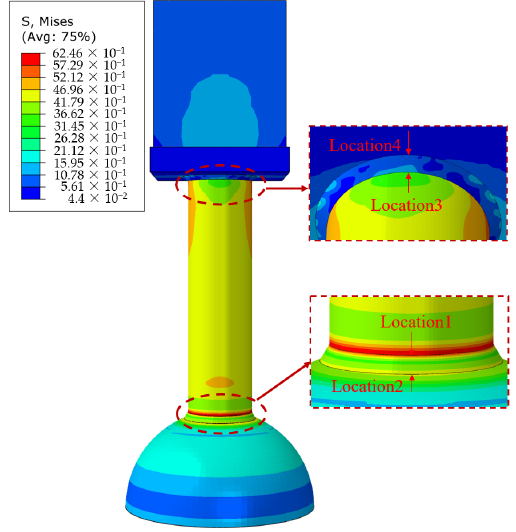
Figure 2. Results of stress concentration analysis.